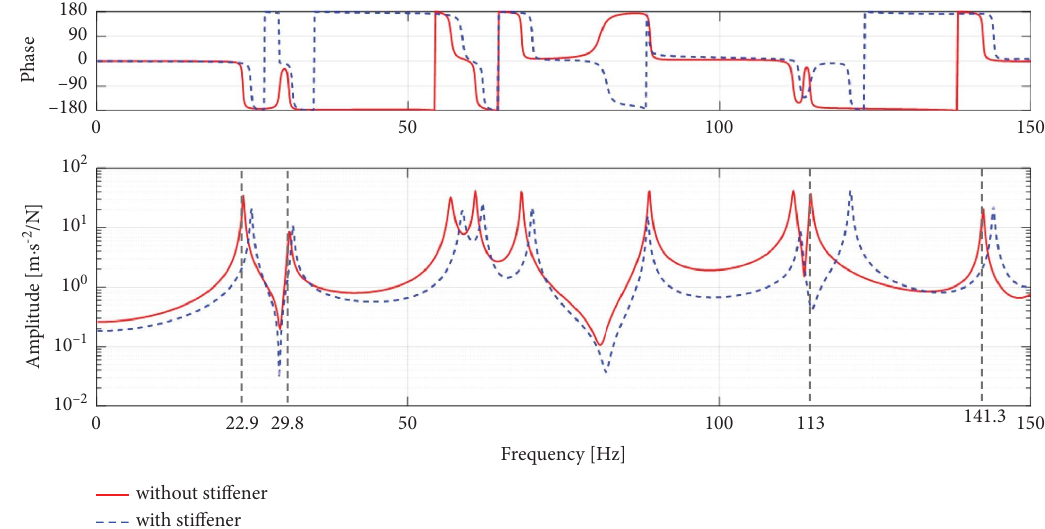
Figure 16: Target FRF before and after modifcation (with same modal damping